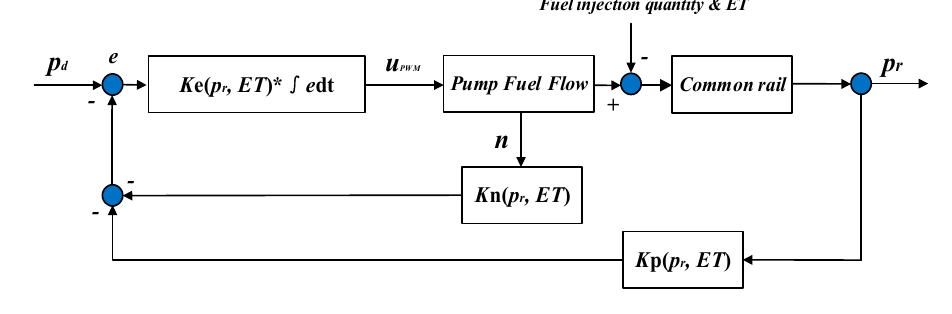
Figure 4. LPV control principle.